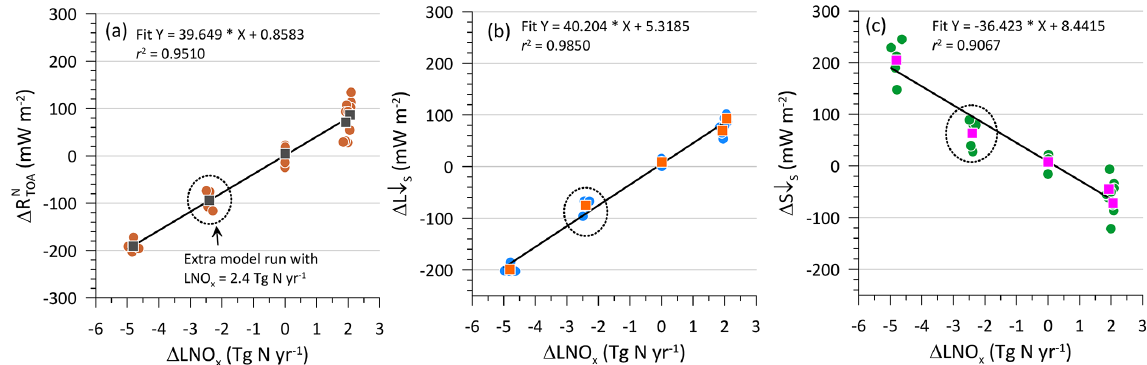
), (b) incoming surface longwave radiation ( (cid:49)L ↓ S ), and Figure 8. Change in the modelled (a) net downward total TOA radiation ( (cid:49)R N TOA (c) incoming surface shortwave radiation ( (cid:49)S ↓ S ), as a function of change in the modelled lightning-generated NO x ( (cid:49) LNO x , TgNyr − 1 ) relative to the base model run. All runs except Run E (i.e. without the CH 4 radiation feedback) are considered. Results from an additional model simulation the same as Run C but with averaged LNO x = 2 . 4TgNyr − 1 are also plotted (enclosed in a dotted circle) to check linearity. The solid circles are the annual means, whereas the squares are the mean over 2006–2010. The best fit line is based on all points.